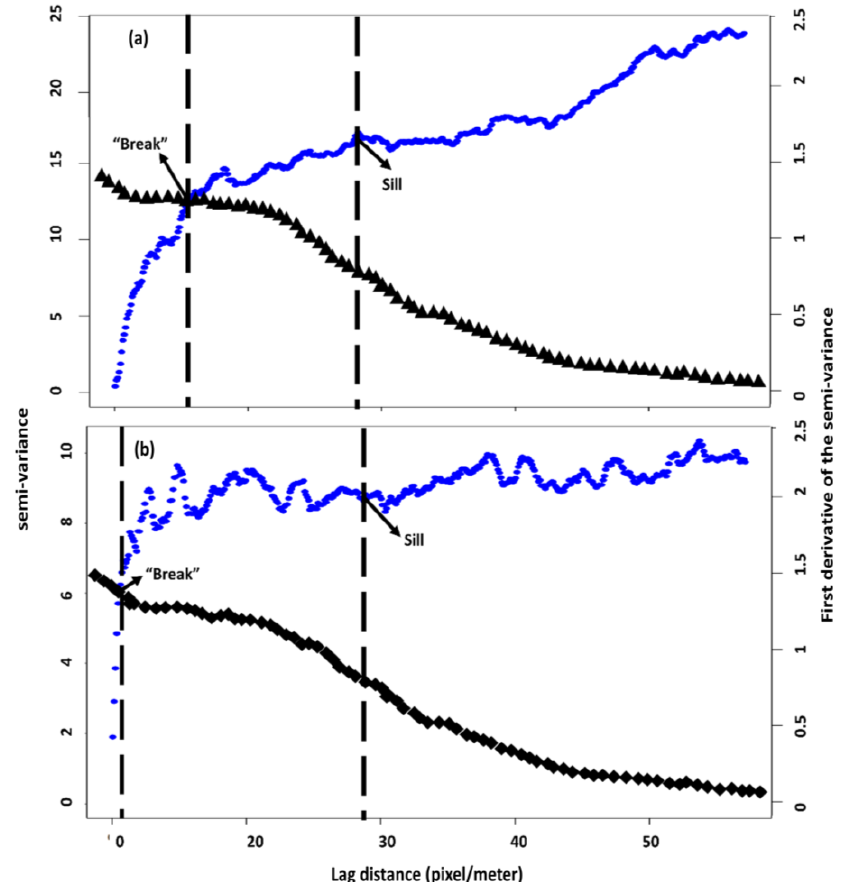
Figure 9. The semi-variogram (blue) of the CHM and its first derivative (black) at the ( a ) PFR site and ( b ) FRIM site. The left vertical dashed line indicates where the break in the slopes of the semi-variogram occurred, and the right vertical dashed line indicates the range where the semi-variogram reached the sill.